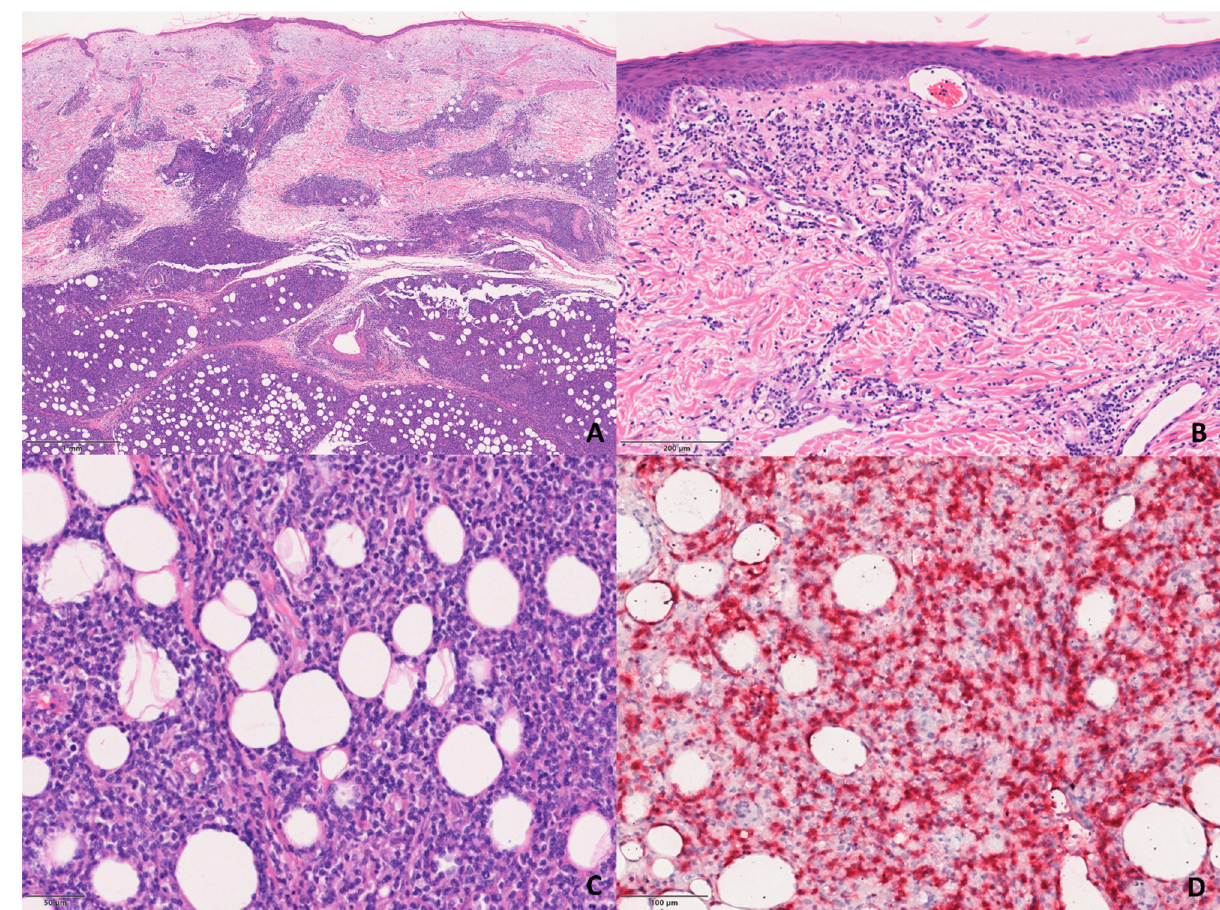
Figure 3. Histological features of the S-GDTCLs. ( A ) Dermal and subcutaneous involvement of the infiltrate. H&E, 200×. ( B ) Detail of the infiltrate in the dermis. H&E, 200×. ( C ) Detail of the lobular infiltrate of pleomorphic lymphocytes in subcutaneous tissue. H&E, 200×. ( D ) TCR δ -positive neoplastic cells in subcutaneous tissue. Immunophosphatase, 200×.